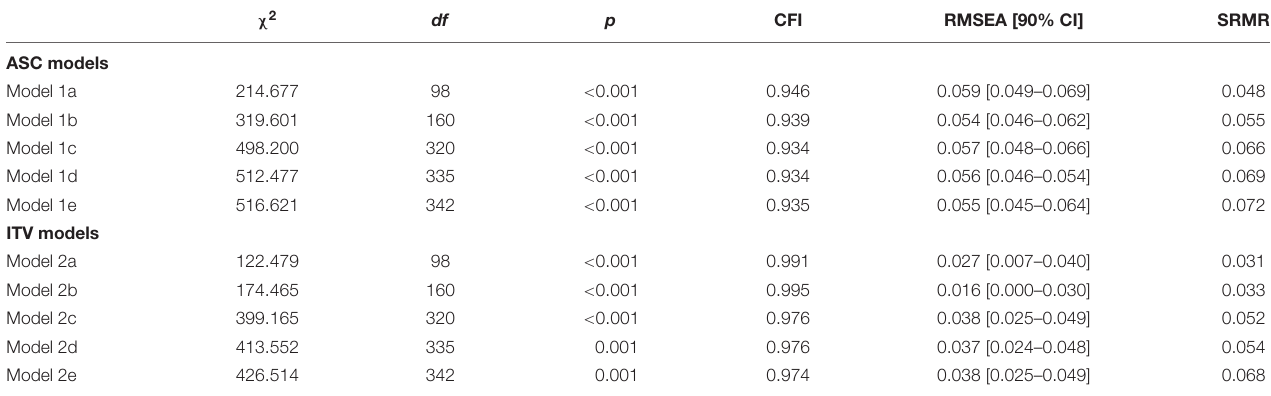
Frontiers in Psychology |